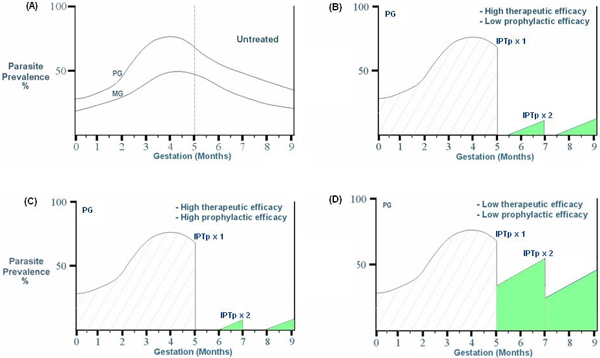
Influence of high and low therapeutic or prophylactic efficacy on parasite burden in primigravidae in high transmission settings. (A) Parasite prevalence in primigravidae (PG) and multigravidae (MG) in unprotected pregnancies (from [2]). The fall in parasite prevalence after four months gestation corresponds to the decline observed if untreated and is related to the development of parity-specific immunity; (B) High therapeutic (100%) and low prophylactic efficacy (≤50%) with two dose SP-IPTp intermittent preventive treatment; (C) High therapeutic (100%) and high prophylactic efficacy (100%); (D) Low therapeutic (≤50%) and low prophylactic efficacy (≤50%).